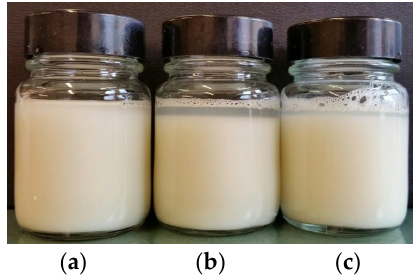
Figure 1. Observations immediately after PTFE was added to the FC ‐ 4 cationic surfactant with a clear boundary between the FC ‐ 4 layer (translucent) and PTFE prior to mechanical agitation. The FC